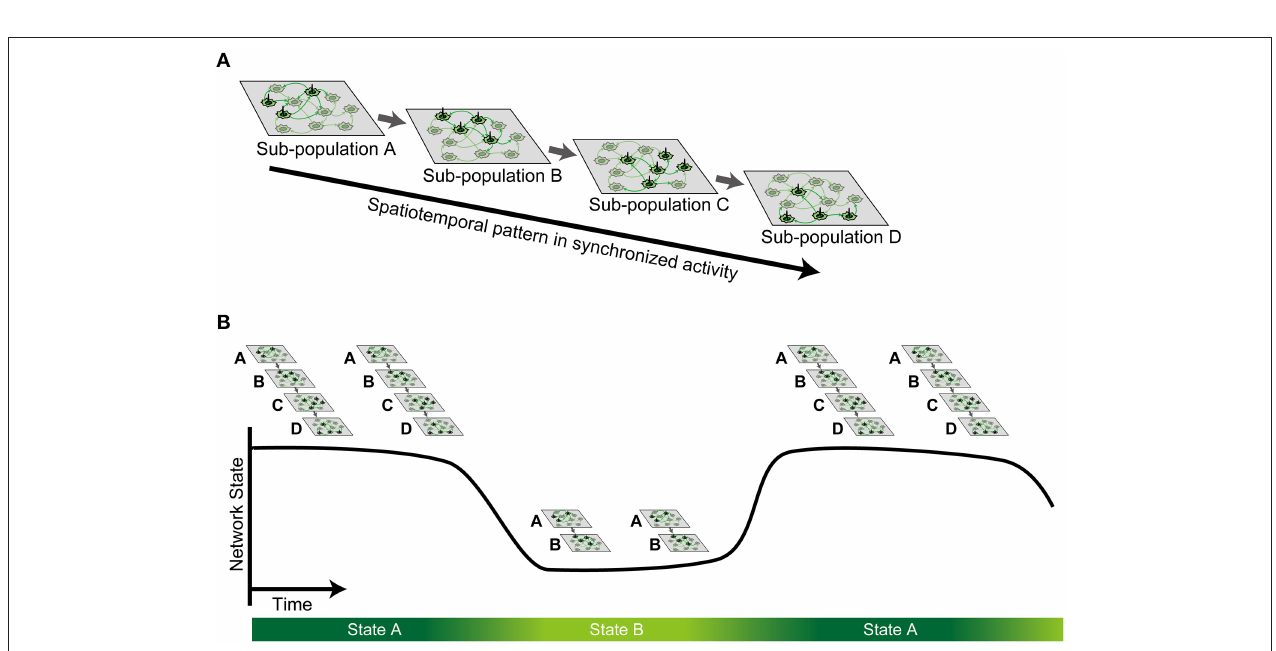
FIGURE 7 | Schematic illustration of the hypothesis. (A) Stable spatiotemporal patterns observed in synchronized spontaneous activity are generated by sequential activation of neuronal sub-population. (B) Such sequential activation of sub-population is state-dependent, whereby multiple metastable states can be defined as a finite continuous